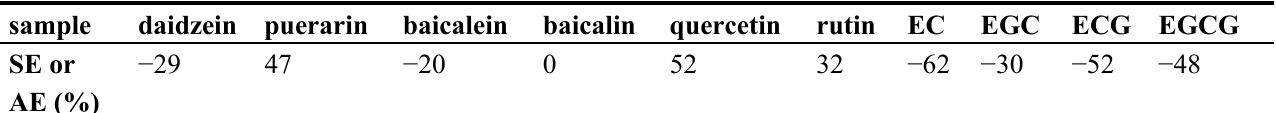
Table 1. Efficiency of antioxidant synergism (SE, positive) or antagonism (AE, negative) in percentage between β -carotene and a number of (iso)flavonoids and their glycosides [61,62,65]. sample daidzein puerarin baicalein baicalin quercetin rutin EC EGC ECG EGCG SE or − 29 47 − 20 0 52 32 − 62 − 30 − 52 − AE (%)